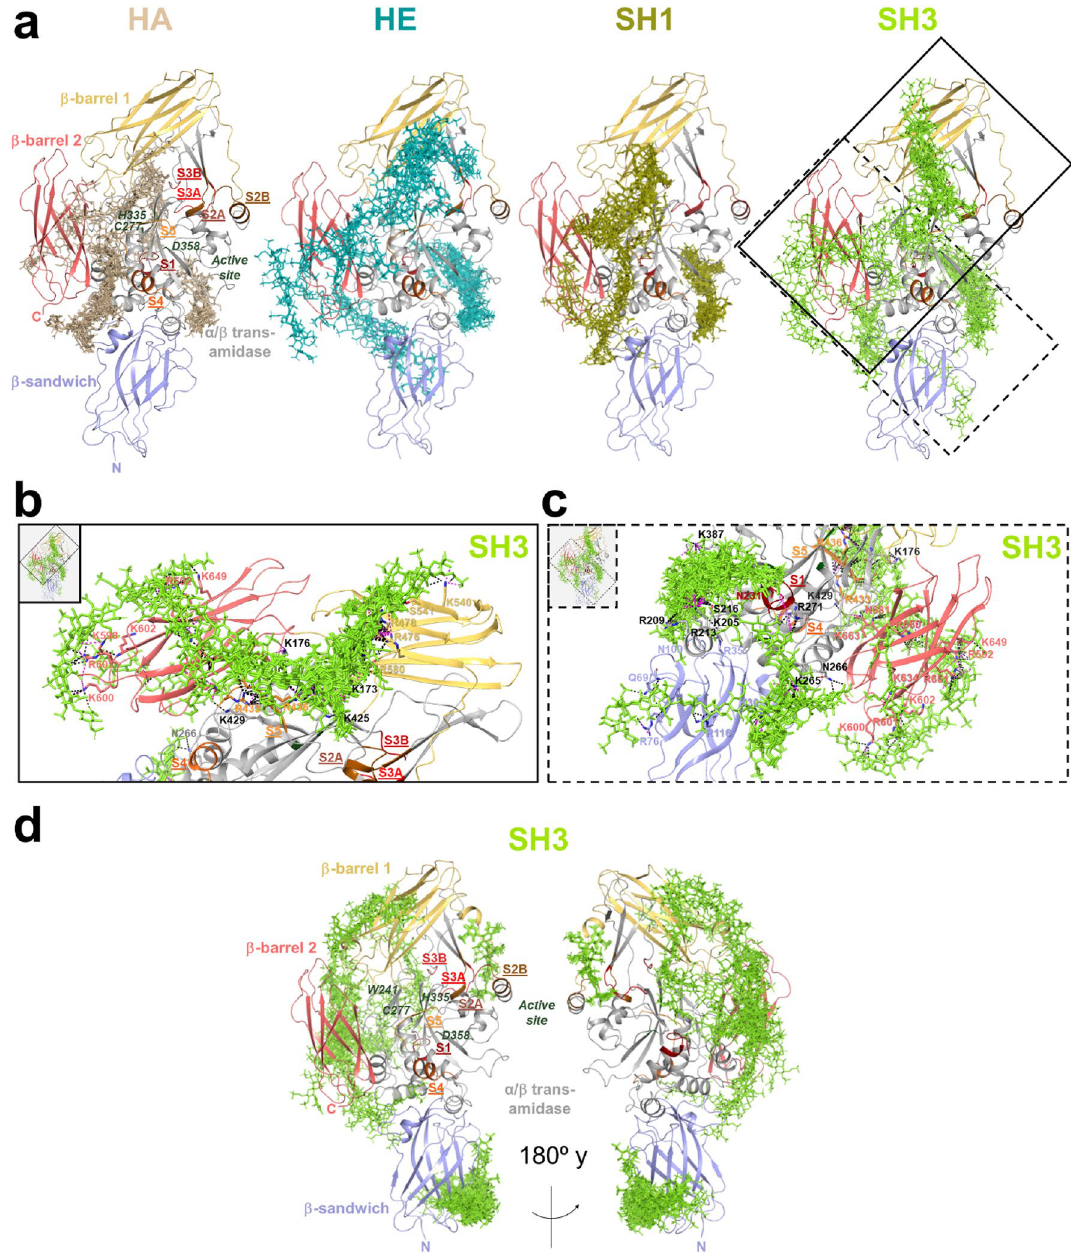
Figure 3. Molecular modeling of the interaction of the investigated GAG derivatives with TG2 in closed conformation. Docking results obtained using Glide for ( a – c ) GAG derivatives and rhTG2 as well as ( d ) SH3 and gpTG2. Protein domains are shown in cartoon: β-sandwich (purple), α/β-transamidase domain (gray), β-barrel 1 (yellow) and β-barrel 2 (salmon). Residues at the active site are highlighted in dark green. Ca 2+ binding sites are highlighted in dark red (S1), brown (S2), red (S3) and orange (S4, S5). The different GAG clusters are shown in sticks: HA (pale), HE (teal), SH1 (smudge) and SH3 (green). The grid boxes ( b ) and ( c ) highlight the close-up view of the predicted interaction of SH3 with rhTG2 according to solid and dashed boxes in ( a ). Figure generated in Maestro (v12.3) 48